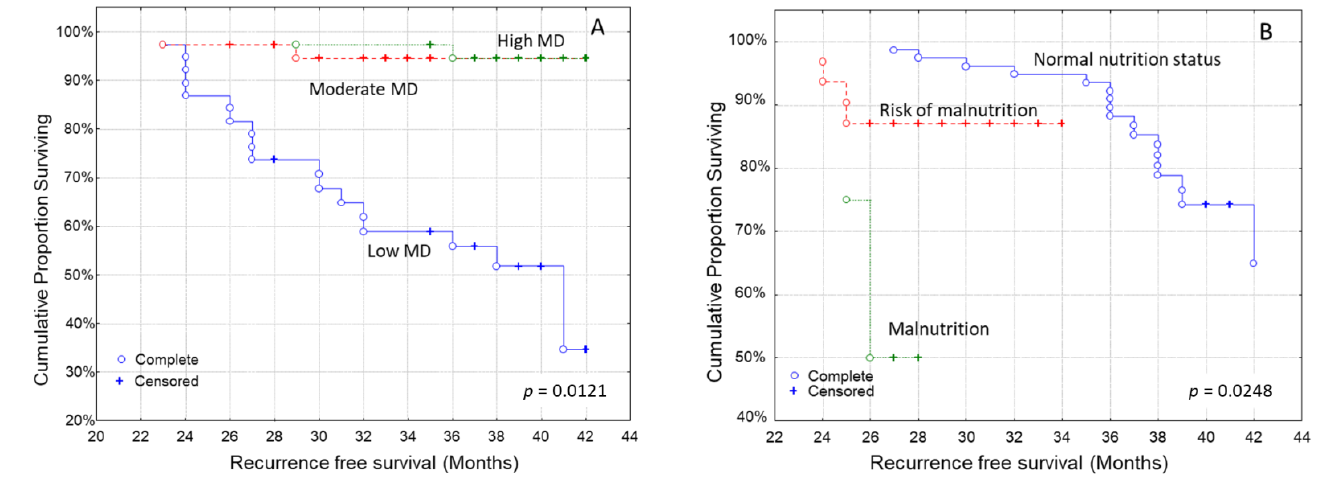
Figure 1. Kaplan–Meier survival analysis stratified according to ( A ) Mediterranean diet (MD) adherence and ( B ) nutritional status in 114 breast carcinoma patients for recurrence- free patients’ sur- vival.